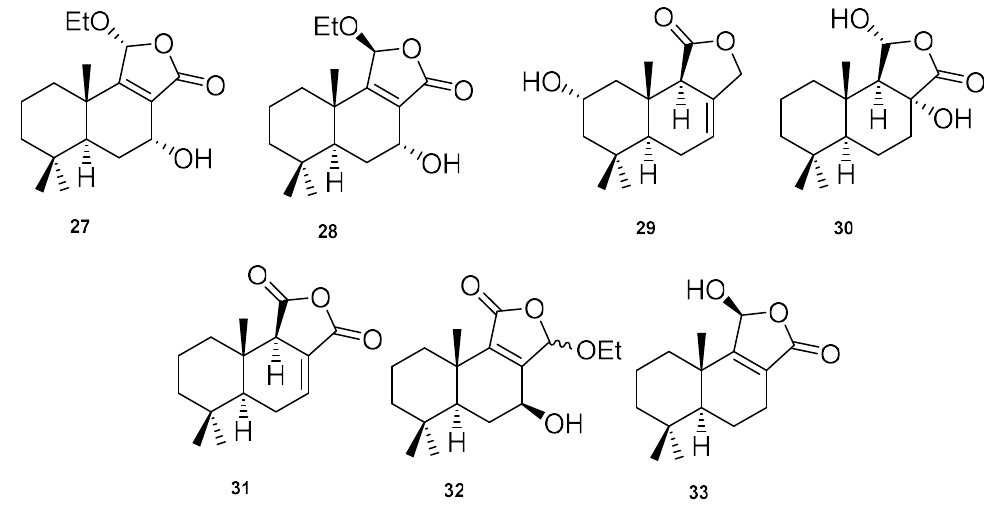
Figure 8. Drimane lactones from Dendrodoris carbunculosa [54].